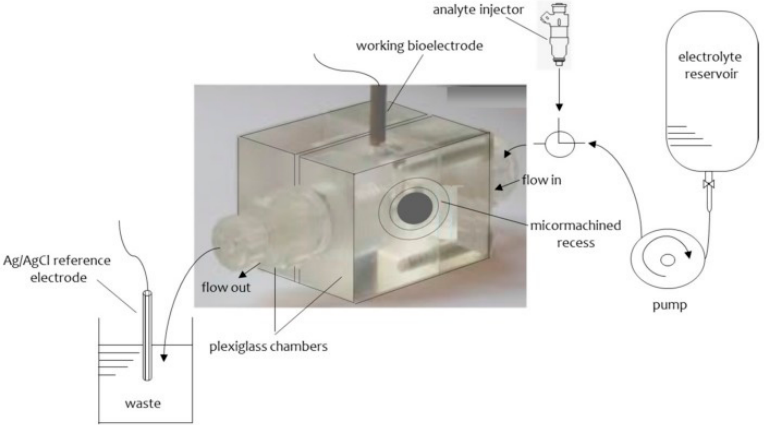
Figure 2. The experimental set-up used for the construction of stable in air lipid membranes supported on glass fiber filters (from Reference [13]).